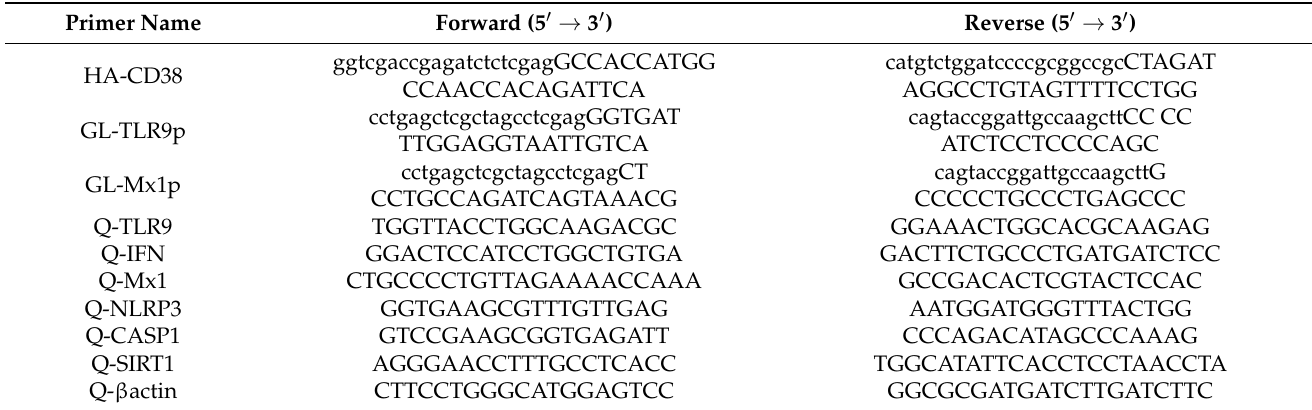
Table 1. Primer pairs used for plasmid construction and quantitative real-time